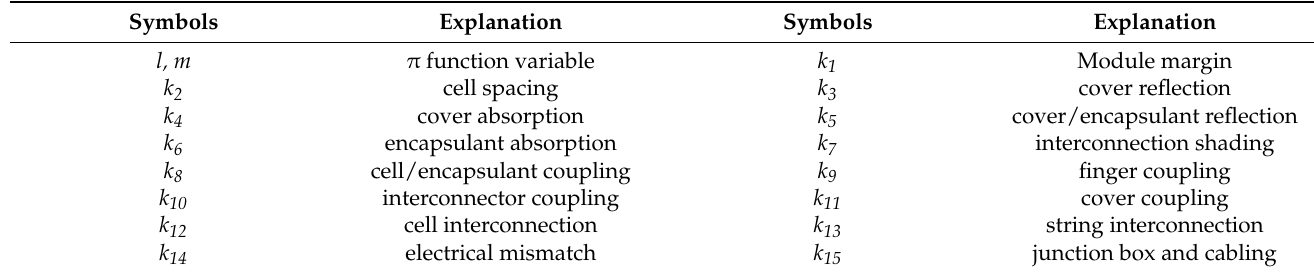
Table 1. Explanation of symbols and abbreviations used in the CTM